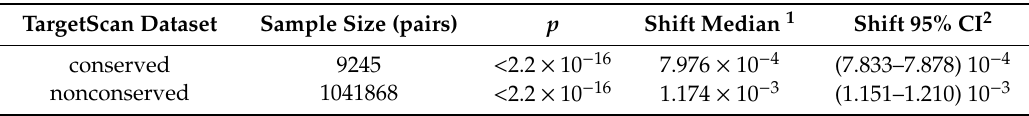
1 Estimated shift median for the difference: European minus African target allele frequency. 2 Confidence Interval.